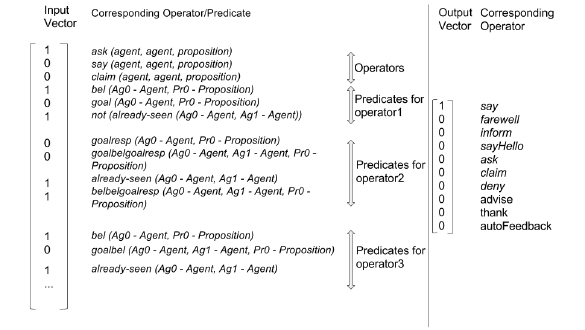
Figure 4: Vector representations for the operator “ask” and succes- sive operator “say” for the learnt behavioral